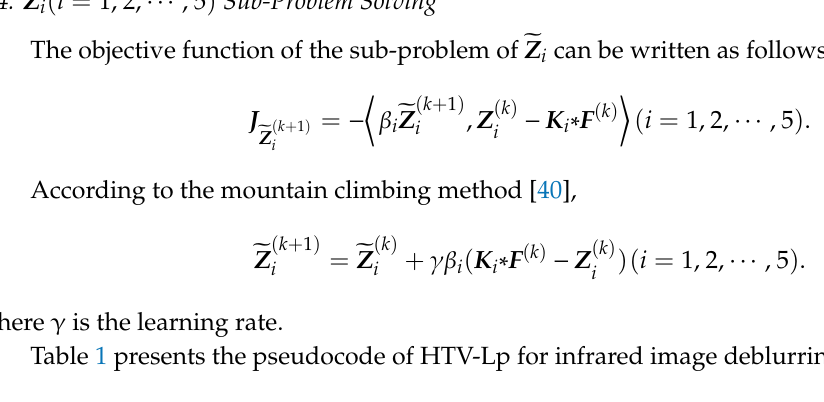
Table 1. The pseudo-code of the proposed